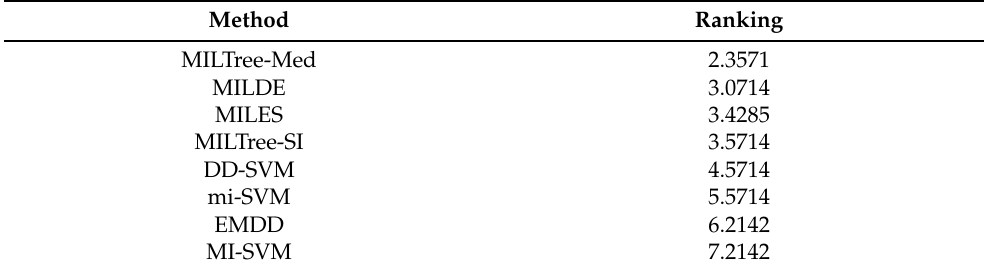
Table 15. Average rankings. Friedman statistic 23.5 according to χ -square with 7 degrees of freedom; p = 0.0014.